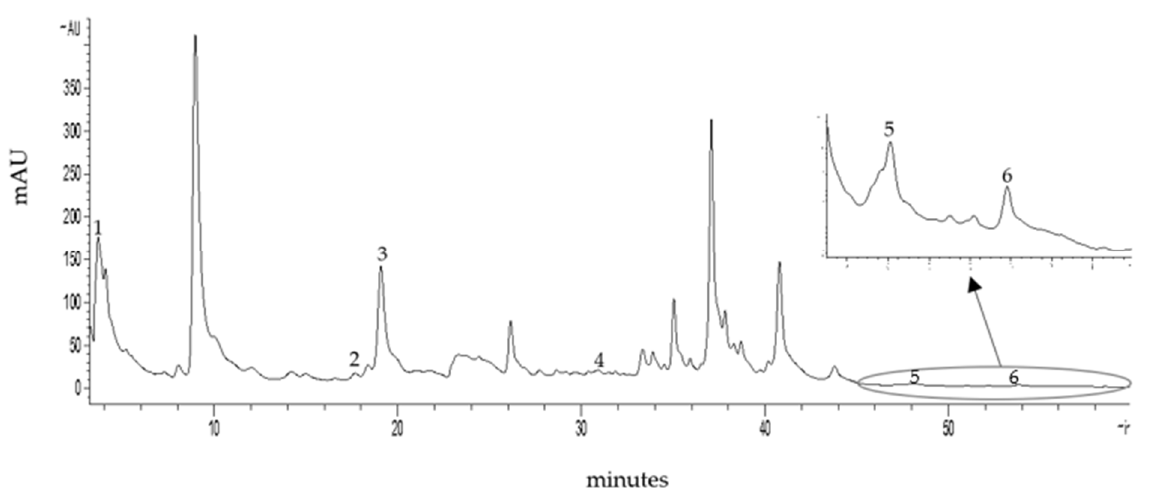
Figure 1. HPLC chromatograms of total phenols shown in the M. oleifera leaf tea from Column, Purospher ® Star PR-18; mobile phase, 0.1% formic acid in water and ACN; flow rate, 0.8 mL/min; detection wavelength, 250 nm. Peak identification: peak 1, gallic acid; peak 2, chlorogenic acid; peak 3, caffeic acid; peak 4, ferulic acid; peak 5, quercetin; peak 6, kaempferol.